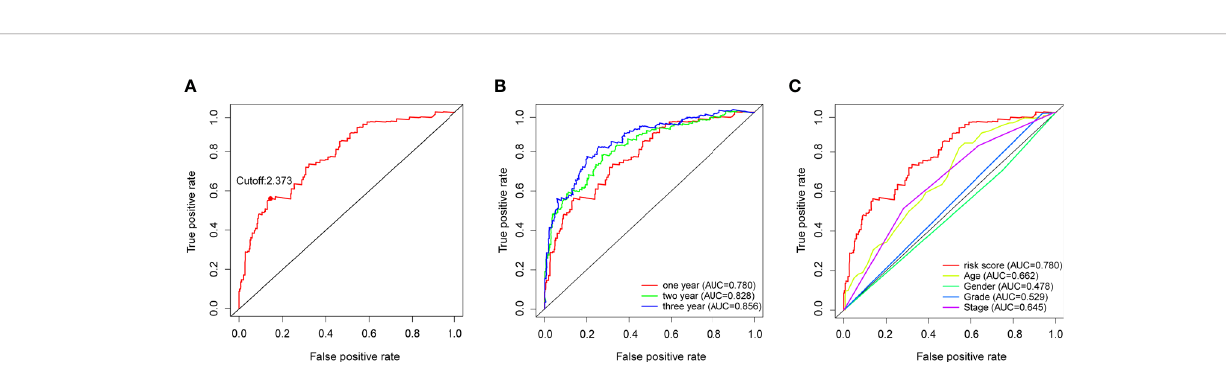
FIGURE 3 | (A) Risk scores for 400 patients with bladder cancer; the maximum in fl ection point is the cut-off point obtained by the AIC. (B) The 1-,3-, and 5-year ROC of the model suggested that all AUC curves were over 0.780. (C) A comparison of 1-year ROC curves with other clinical characteristics showed the superiority of the risk scores.